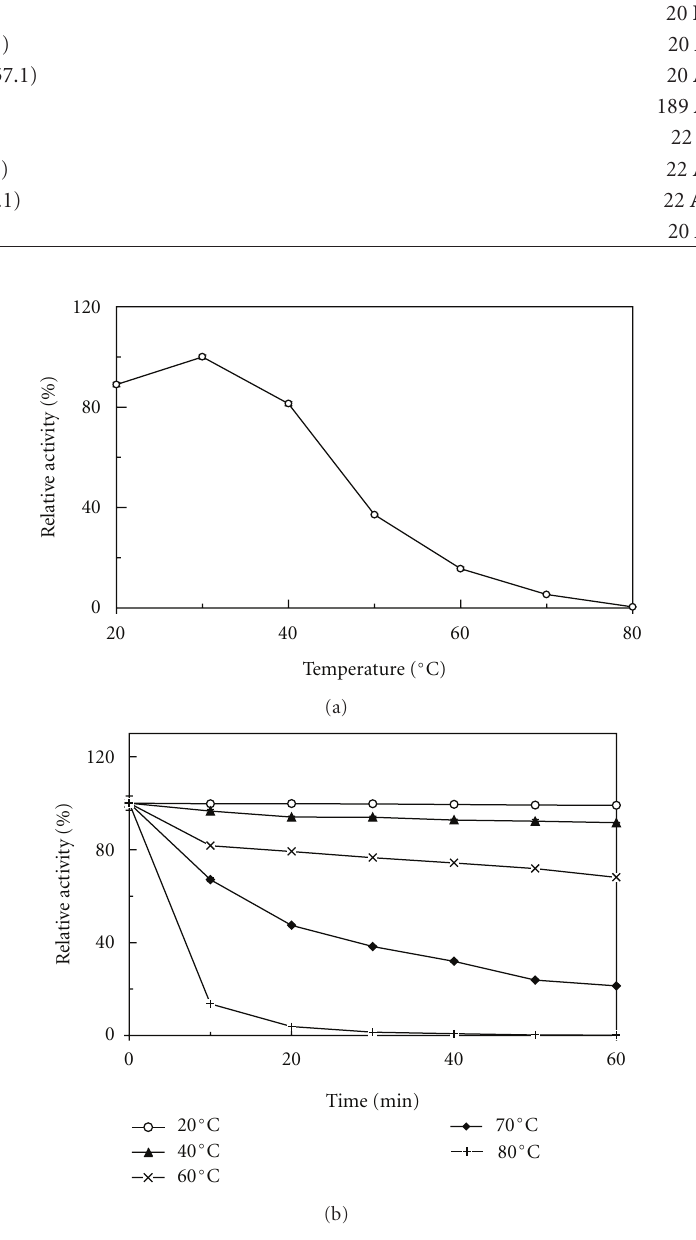
Figure 3: Temperature optimum and thermal stability of A. placomyces laccase. (a) E ff ect of temperature on A. placomyces laccase. (b) A. placomyces